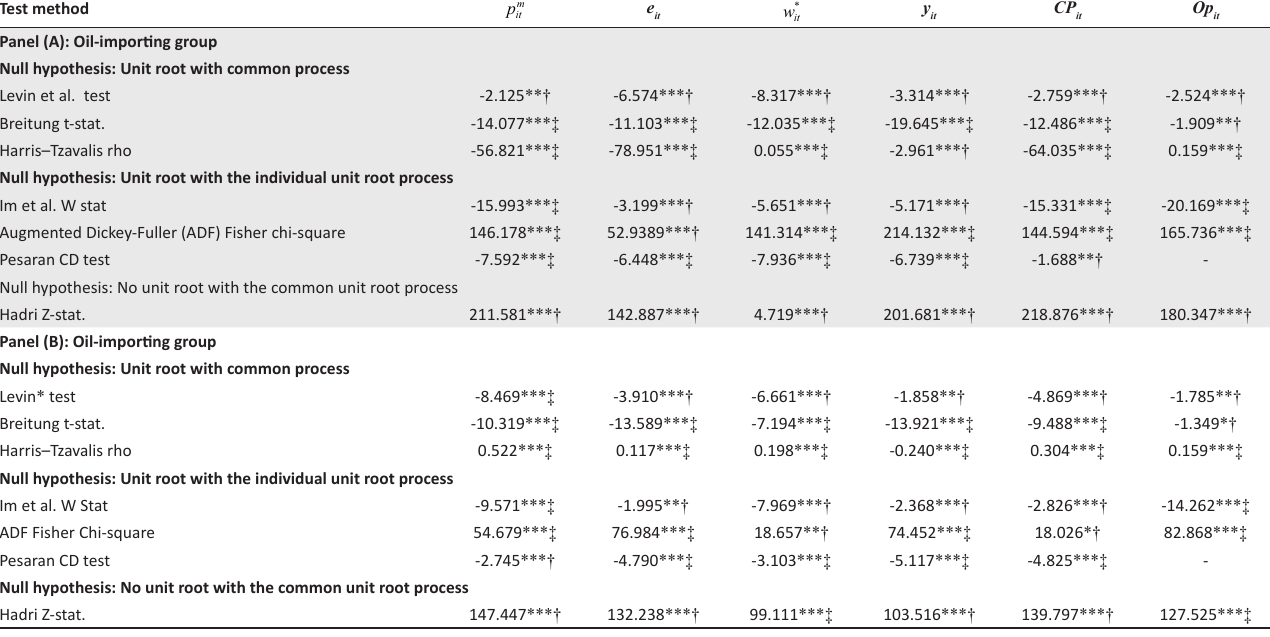
TABLE 1: Panel unit root test results. Test